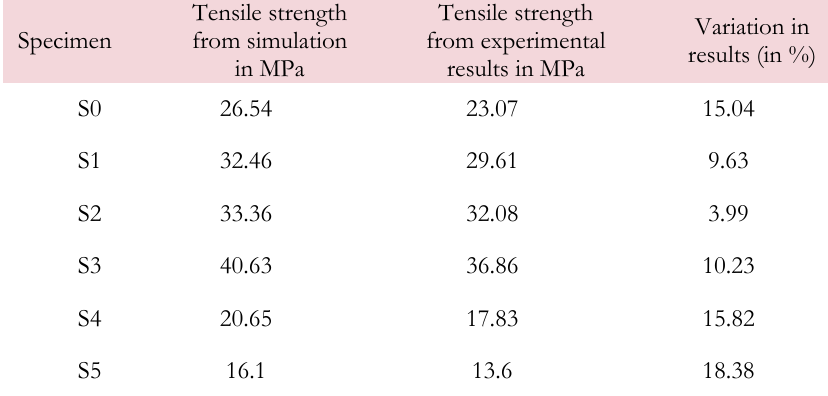
Table 4: Simulation results for the samples